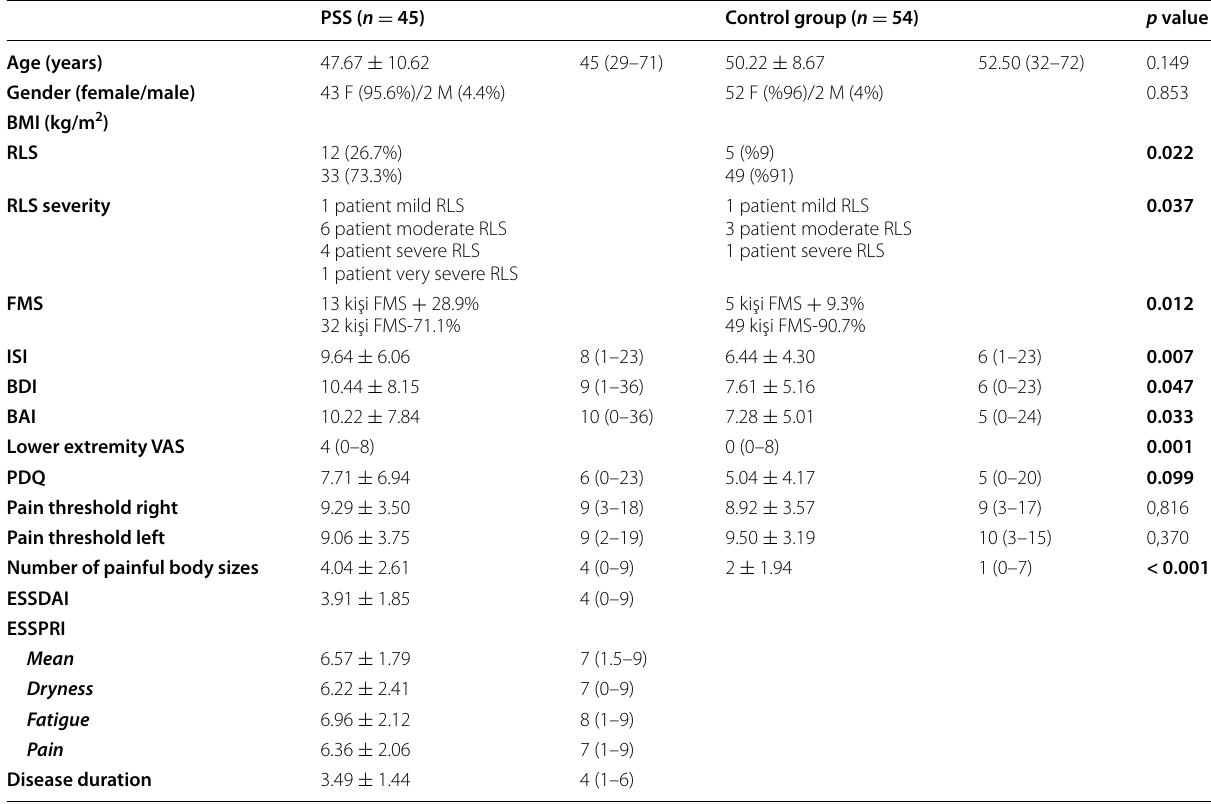
Table 1 Demographic and disease-related characteristics of patients with primary Sjögren’s syndrome and demographic data of healthy